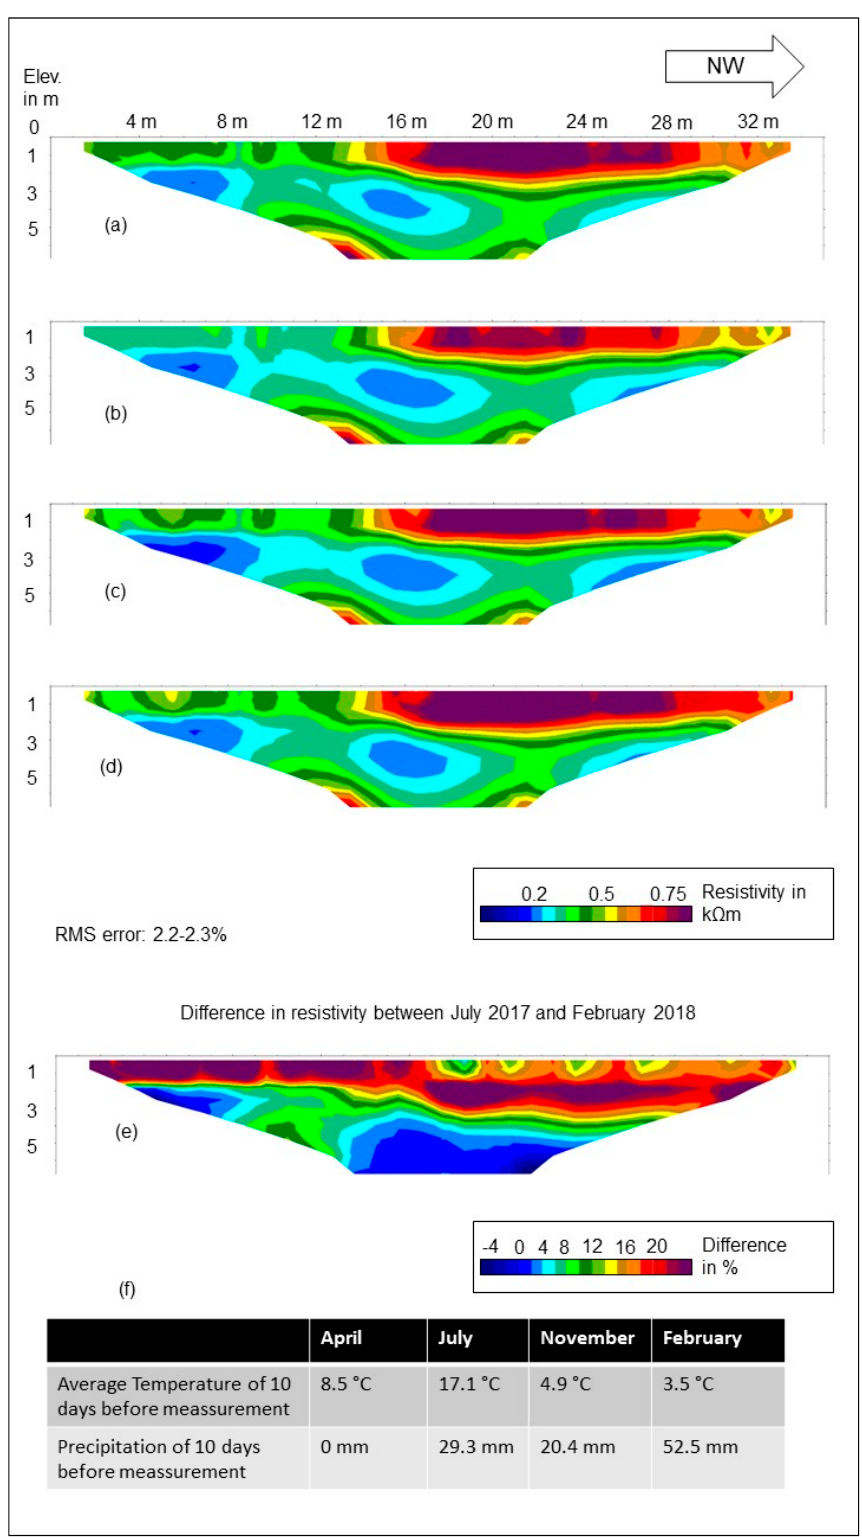
Figure 6. Geoelectrical Monitoring1: ( a ) Electrical Resistivity Tomography (ERT) data from April 2017, ( b ) ERT data from July 2017, ( c ) ERT data from November 2017, ( d ) ERT data from February 2018, ( e ) percentage difference between July and February, ( f ) table of meteorological conditions during measurements.